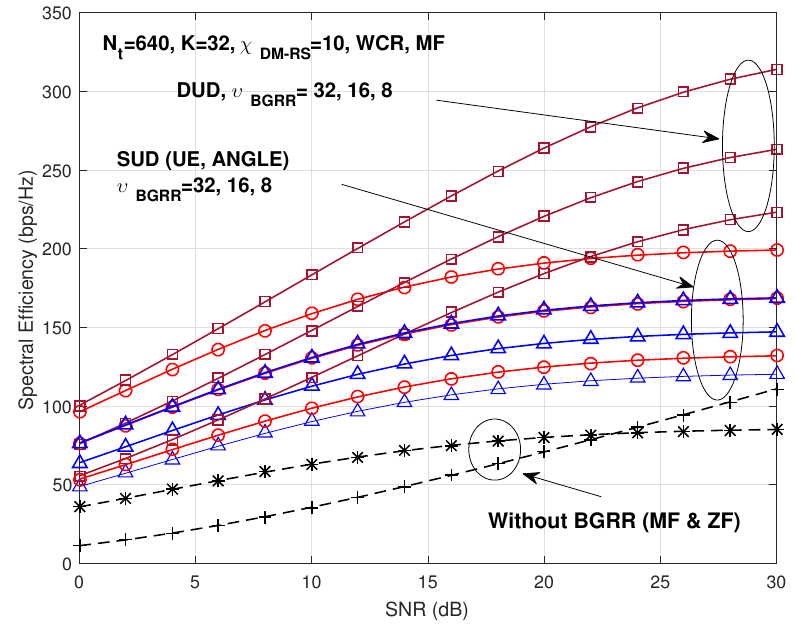
Figure 10. SE versus SNR (dB), when N t = 640, K = 32, χ DM − RS = 10, υ BGRR = 32,16,8, MF group precoding. Red solid lines with ’ O ’ marks are the UE based grouping and blue solid ’ (cid:52) ’ marks are the angle based